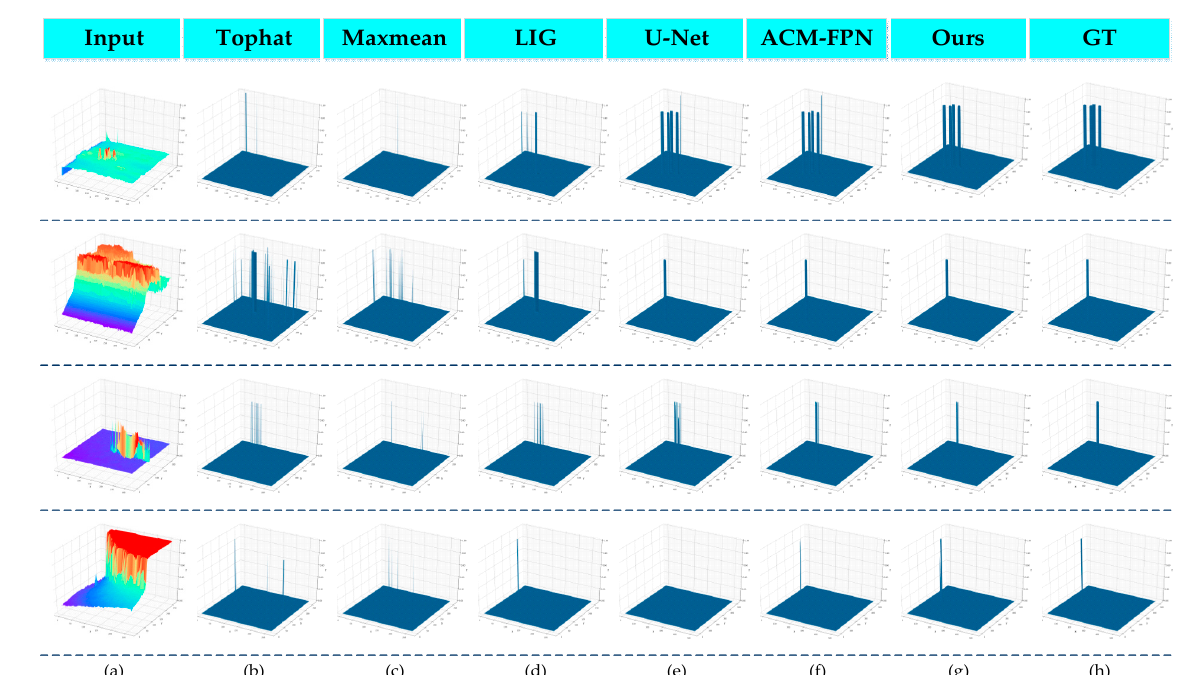
Figure 6. 3D visualisation results of different methods on four test images.